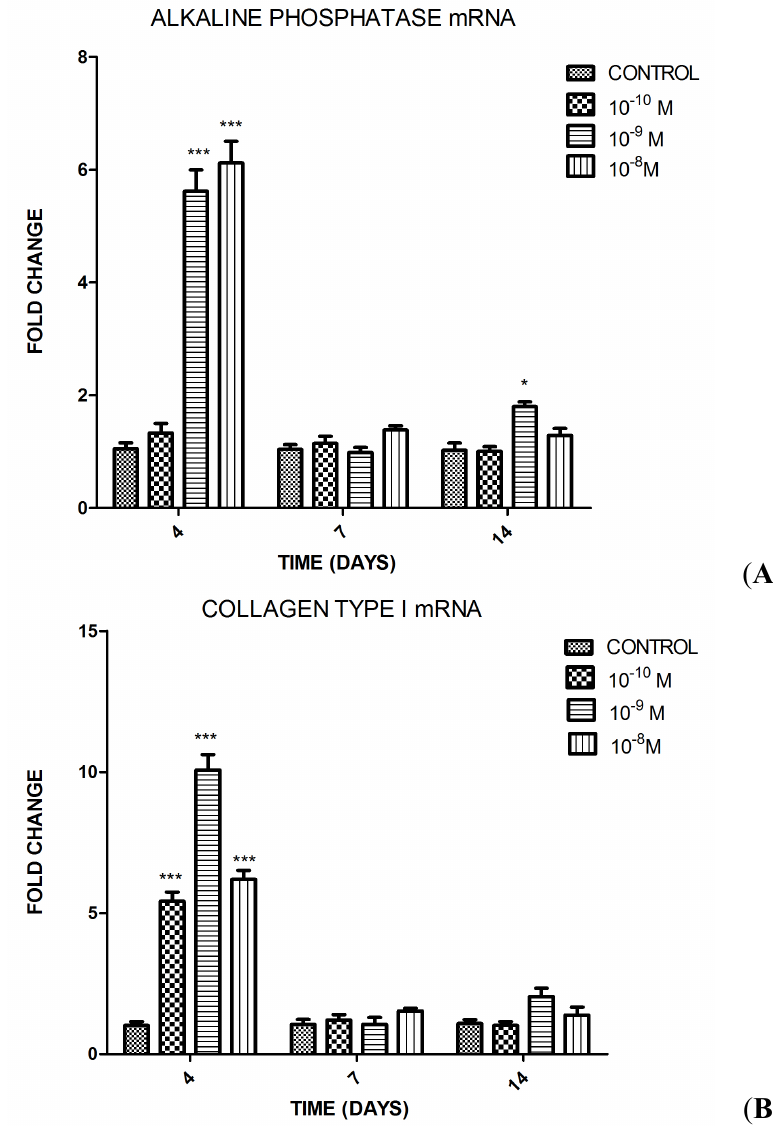
Figure 2. Effects of substance P (SP) treatment at days 4, 7, and 14 (10 − 8 , 10 − 9 and 10 − 10 M) on gene expressions in MC3T3-E1 cells measured by qPCR for ( A ) alkaline phosphatase; ( B ) collagen type I; ( C ) osteocalcin; and ( D ) Runx2 mRNA levels. The values reported are the mean ± SEM of three independent experiments. * p < 0.05 versus Control; ** p < 0.01 versus Control; and *** p < 0.001 versus